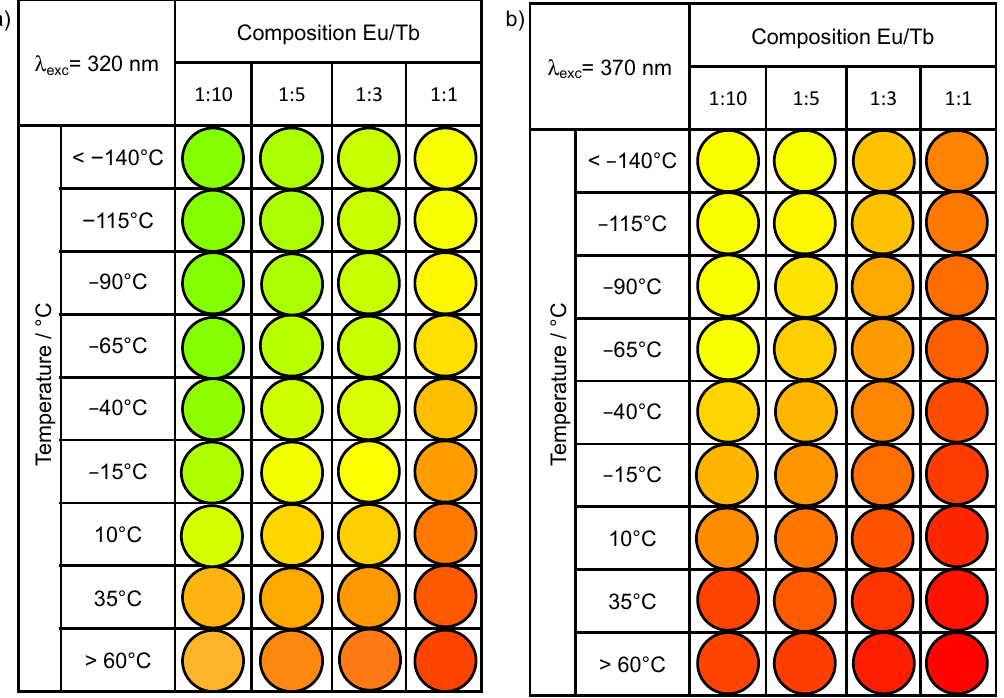
Figure 10. Overall chromatic variation for the studied samples excited at ( a ) 320 nm and ( b ) 370 nm.